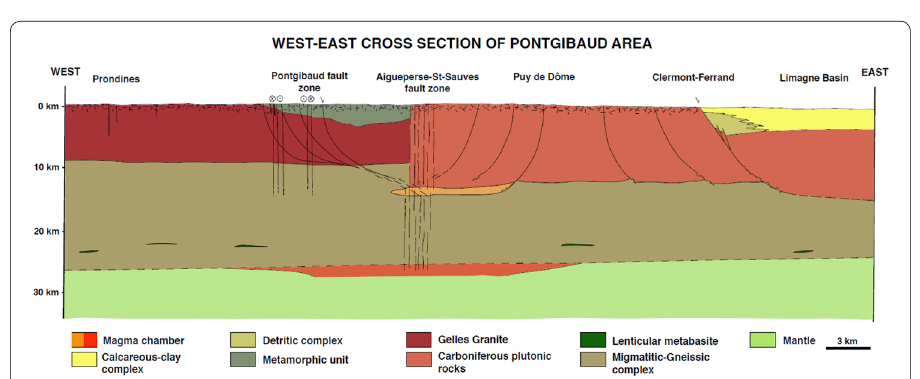
Fig. 7 Synthetic and simplified geological cross‑section of the Pontgibaud area